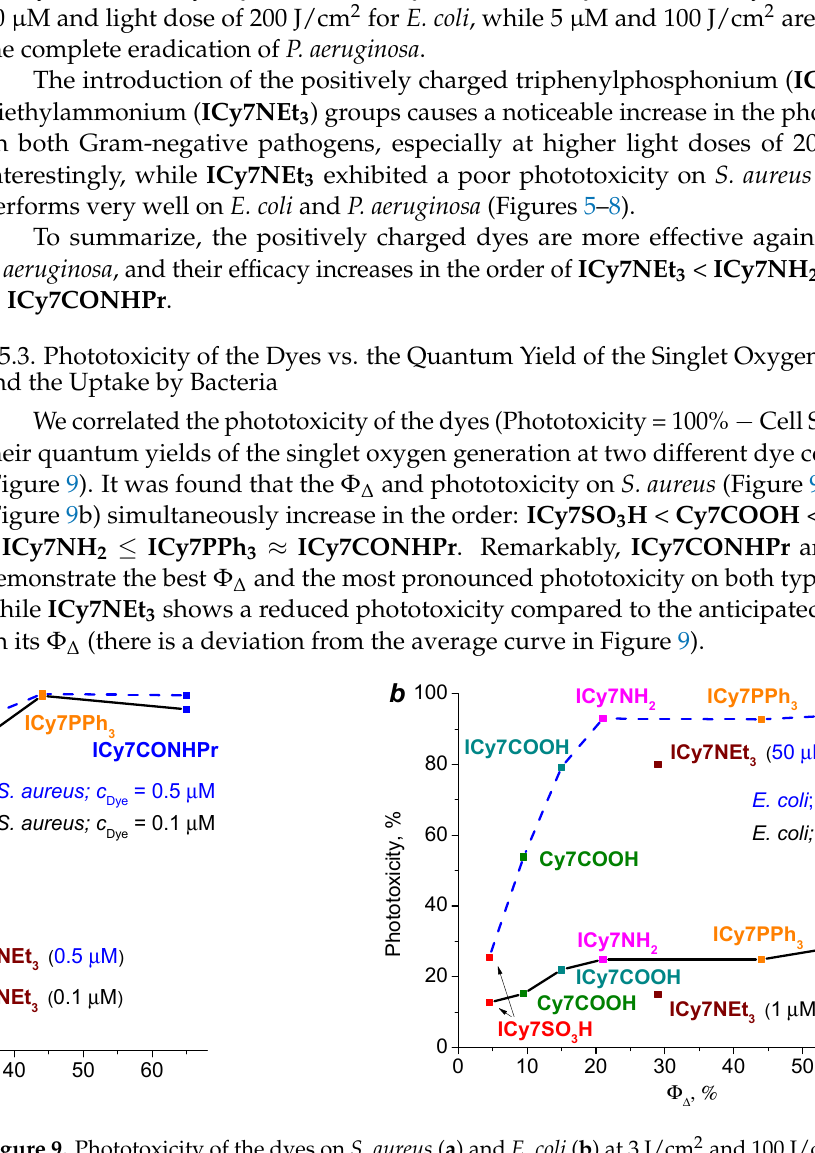
Figure 10. Phototoxicity of the dyes vs. the uptake by S. aureus at c Dye = 0.1 µM ( a ).and E. coli at c Dye = 1 µM ( b ). The light doses are 3 J/cm 2 and 100 J/cm 2 , respectively. Taking into account the obtained data on the dye uptake (Figure 10) and Φ Δ (Table 1 and Figure 9), it can be concluded that the reduced phototoxicity of Cy7SO 3 H is con- nected with its insufficient Φ Δ , while the low phototoxicity of ICy7NEt 3 and Cy7COOH is due to the decreased uptake.